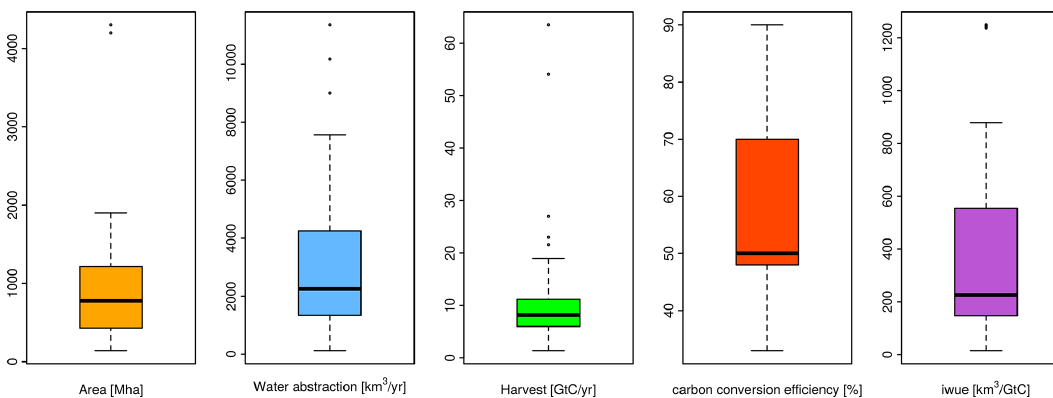
Figure 1. Range of key parameters (global estimates) determining projections of water abstractions for bioenergy in the scenarios examined (see supplementary data; Stenzel et al., 2021) presented as boxplots. Note that plantation area and carbon conversion efficiency are not reported in all studies. Inverse water-use efficiency per biomass harvest (iwue) is calculated for each scenario using the means of water abstractions and biomass harvest if ranges are